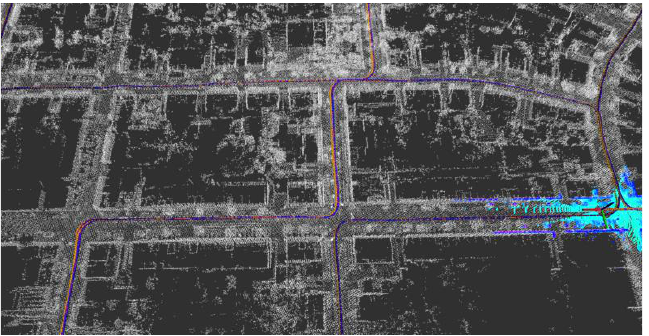
Figure 8. LiDAR localization based on prior KITTI point cloud map; the white points in the figure are the point cloud map built by the offline mapping process, the red line is the trajectory of LiDAR matching results, the orange line is groundtruth, and the blue line is the fused